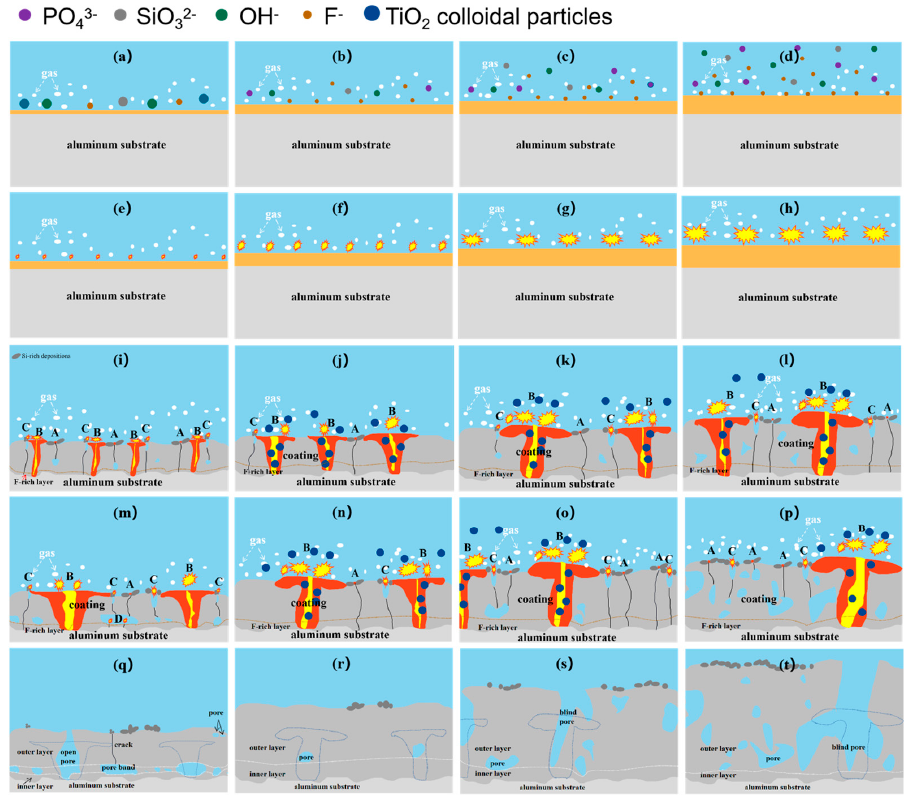
Figure 12. Growth mechanism model of the MAO coatings for different samples: ( a , e,i , m , q ) Ti0 ‐ 15, ( b , f , j , n , r ) Ti5 ‐ 15, ( c , g , k , o , s ) Ti5 ‐ 25 and ( d , h , l , p , t ) Ti ‐ 35. ( b , f , j , n , r ) Ti5-15, ( c , g , k , o , s ) Ti5-25 and ( d , h , l , p , t )